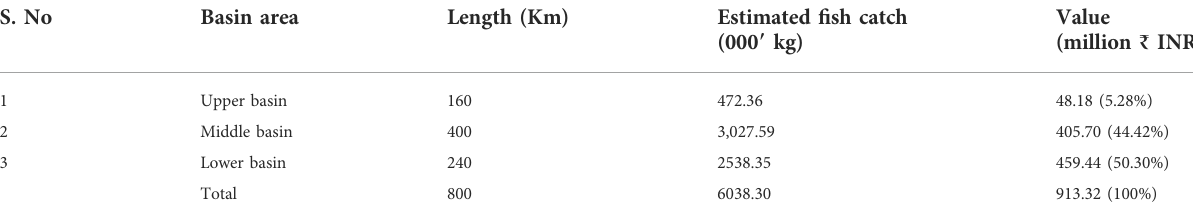
TABLE 3 Value of estimated fi sh production in Cauvery River during 2018 – 19. S.